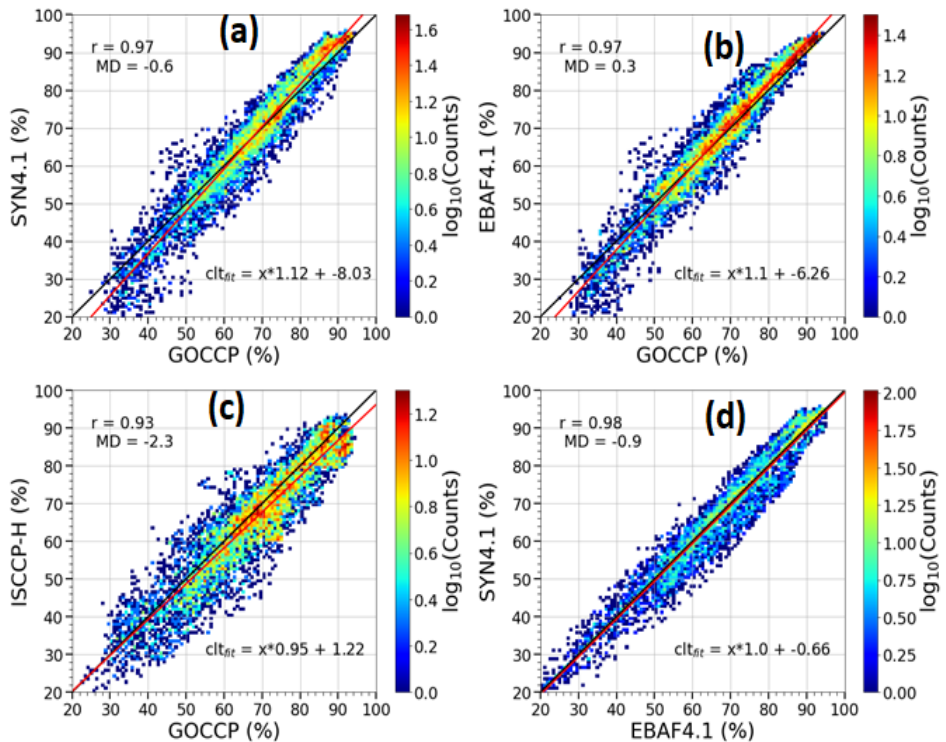
Figure 1. The 2D density plots of annually averaged TCC obtained based on EBAF4.1 ( a ), SYN4.1 ( b ), and ISCCP-H ( c ), and against the TCC obtained from the CALISO satellite. Comparison of the two CERES products, EBAF4.1 and SYN4.1, and ISCCP-H ( c ), and against the TCC obtained from the GOCCP-CALIPSO satellite. Comparison is shown in the fourth column ( d ). The red lines represent the linear fit equations also shown. represent the linear fit equations also